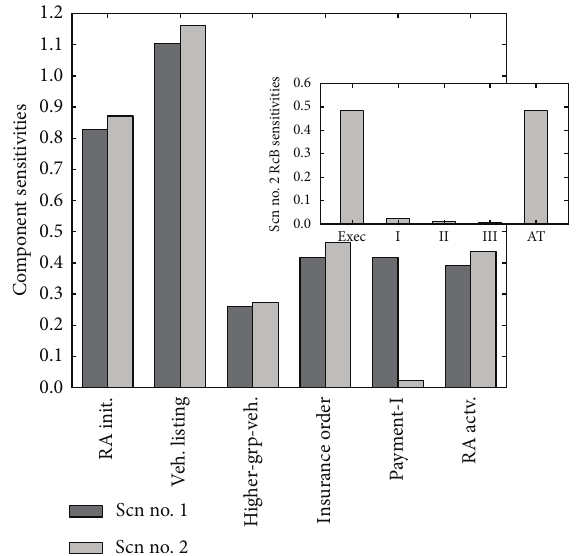
Table 6: Sensitivity analysis for scn. no. 2. Figure 4: Component sensitivities. The main figure shows com- ponent sensitivity comparisons of scenarios no. 1 and no. 2. The subfigure shows the RcB internal sensitivities of the payment service in scenario no.